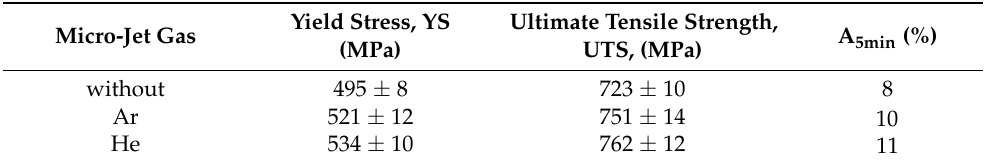
Table 4. Tensile tests results of welded Docol 1200 M steel without the use of micro-jet cooling ± measurement uncertainty.